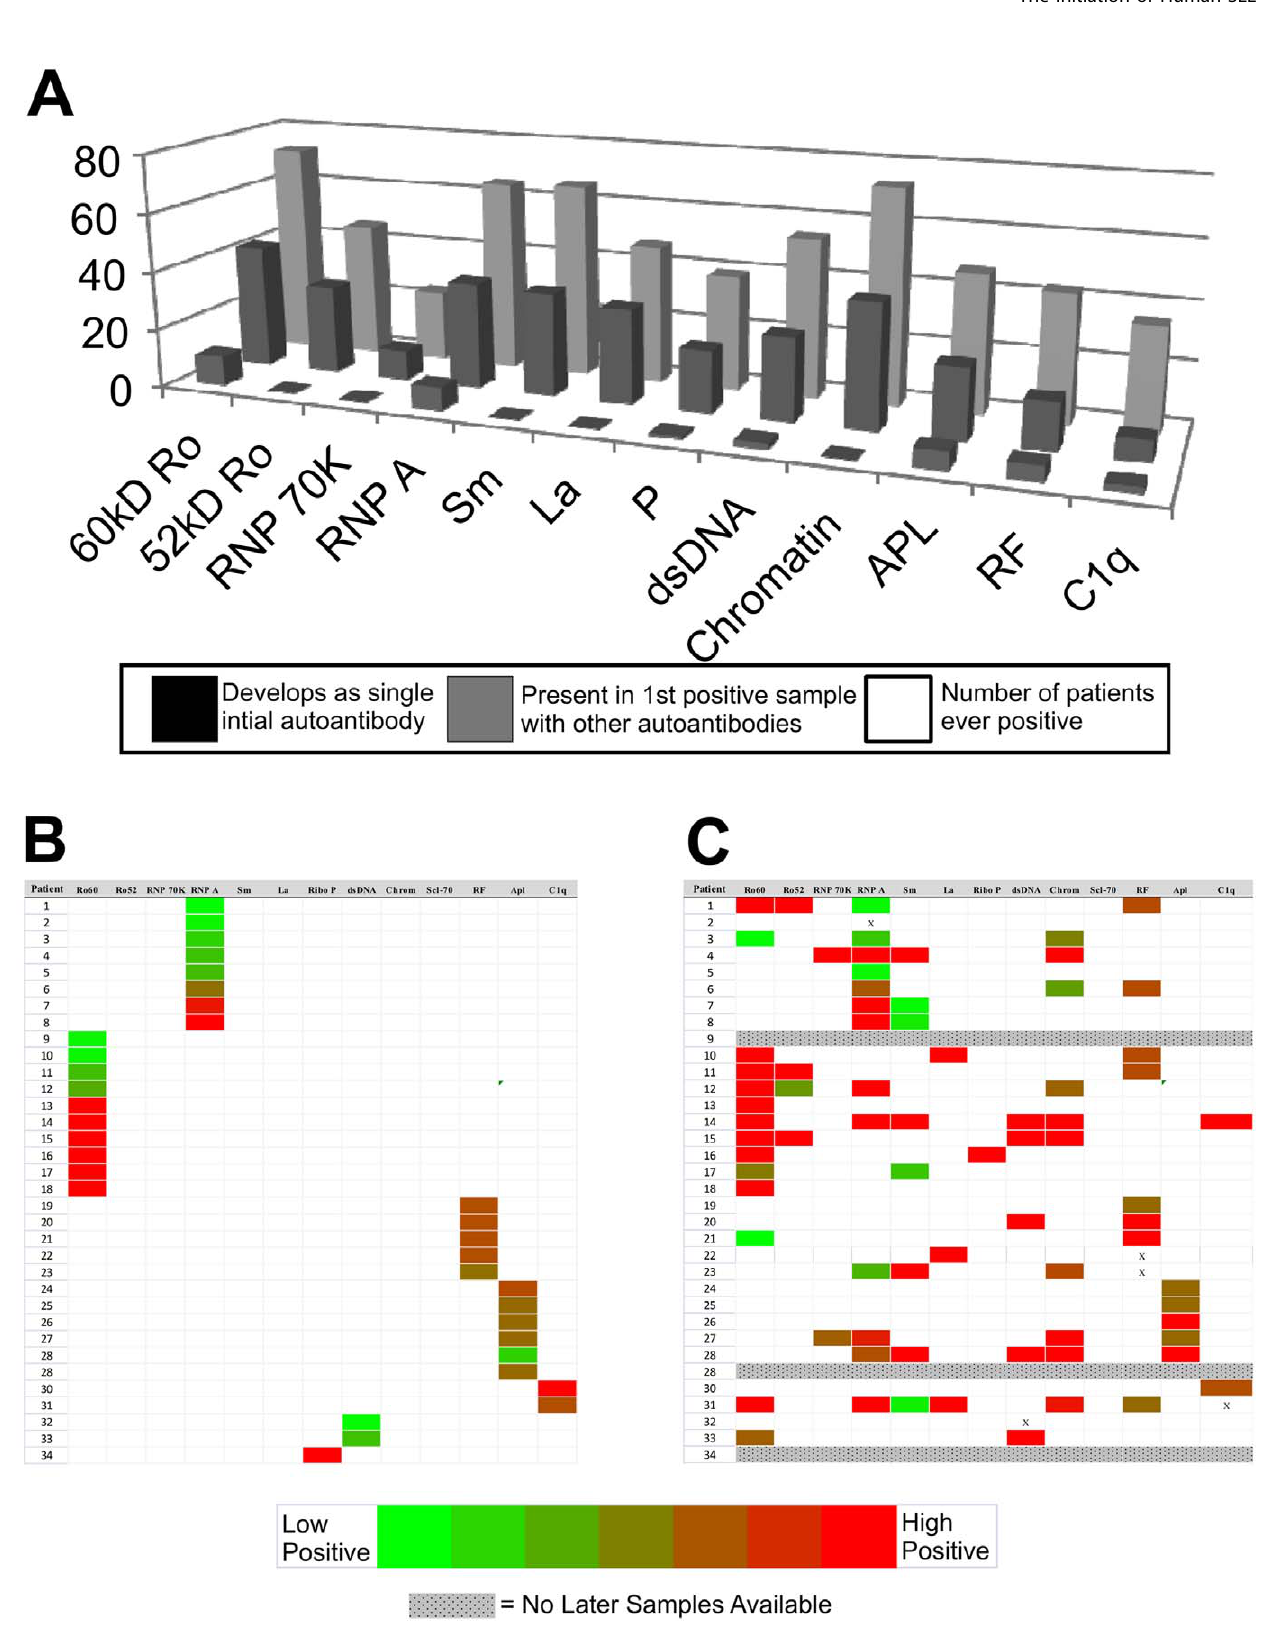
Figure 2. Initial autoantibody targets in the pre-diagnosis cohort. (A) The front (black) bars show the number of patients developing antibodies to respective antigen as their initial single autoantibody specificity. The middle (dark gray) bars show the number of patients with antibodies to the respective antigen in their first positive sample, which includes individuals who had multiple autoantibody specificities in their earliest positive serum. The back (light gray) bars show the total number of patients ever positive for each specificity. (B) Initial autoantibody profiles